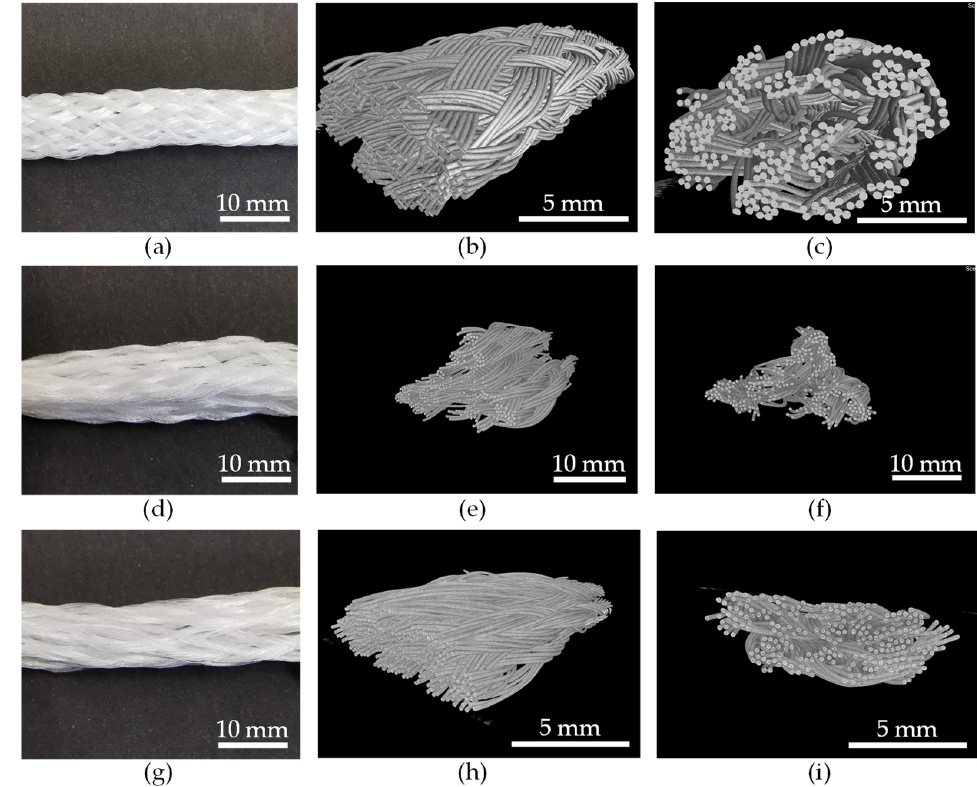
Figure 13. Different 3D braided scaffold designs manufactured on the 3D hexagonal braiding ma- chine: ( a – c ) “multilayer braid”, ( d – f ) “three-tube braid”, ( g – i ) “six-tube braid”; ( a , d , g ) photographs, ( b , c , e , f , h , i ) micro-computed tomography (µ-CT) scans.